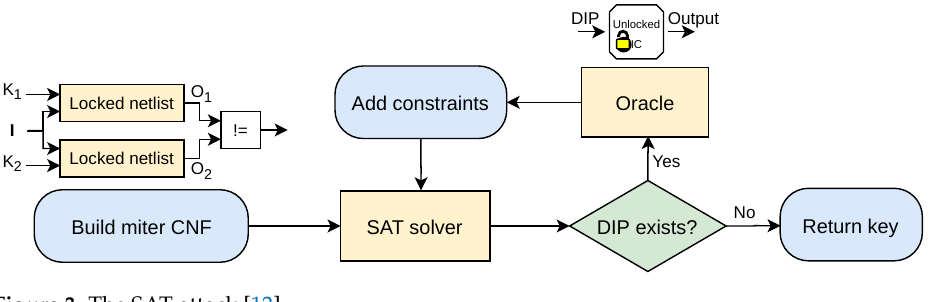
Figure 3. The SAT attack